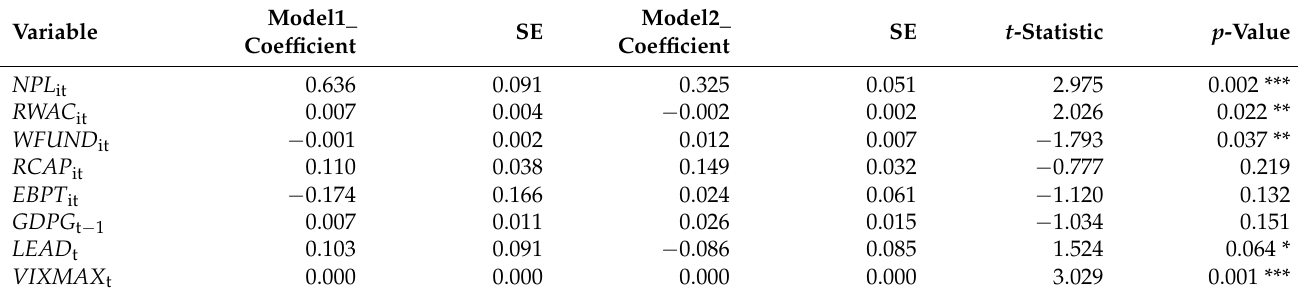
Table A16. Comparison of pre-crisis (adjusted) (2) and crisis (adjusted) (4).